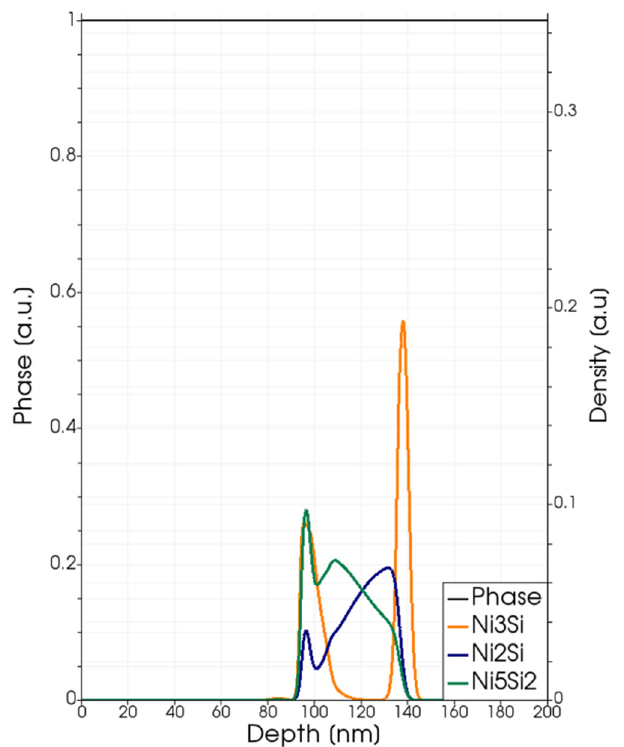
Figure 9. Phase-field (black line and left axis) and simulated local density (right axis scale) of the Ni 3 Si (dark yellow lines), Ni 5 Si 2 class (dark green lines) and Ni 2 Si (blue lines) at the end of a laser annealing process with fluence (cid:1831) (cid:3031)(cid:3032)(cid:3041)(cid:3046) (cid:3404) 3.2(cid:1836)/(cid:1855)(cid:1865) (cid:2870) . Lateral snapshots a), b), c), d) are taken at t = 120, 160, 200, 350 ns, while the central plot refers to the end of the process.